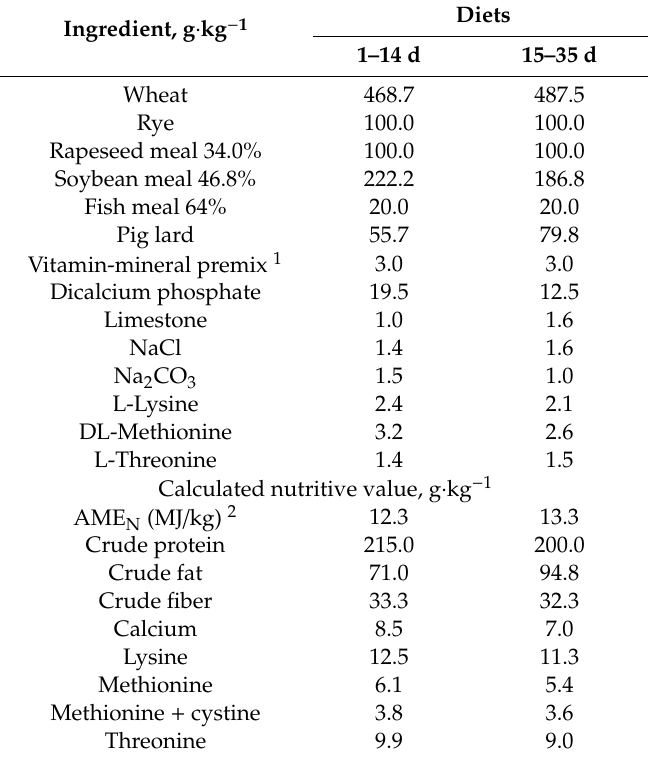
Table 1. Composition and nutritive value of the basal diets, experiments 1 and